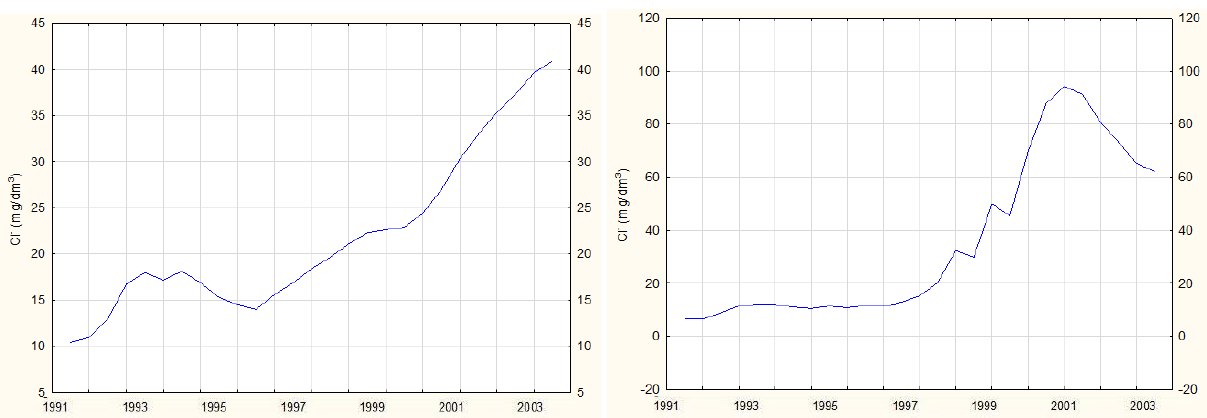
Fig. 5. Changes in chloride content in piezometers T1 and Q1 obtained with the exponential smoothing